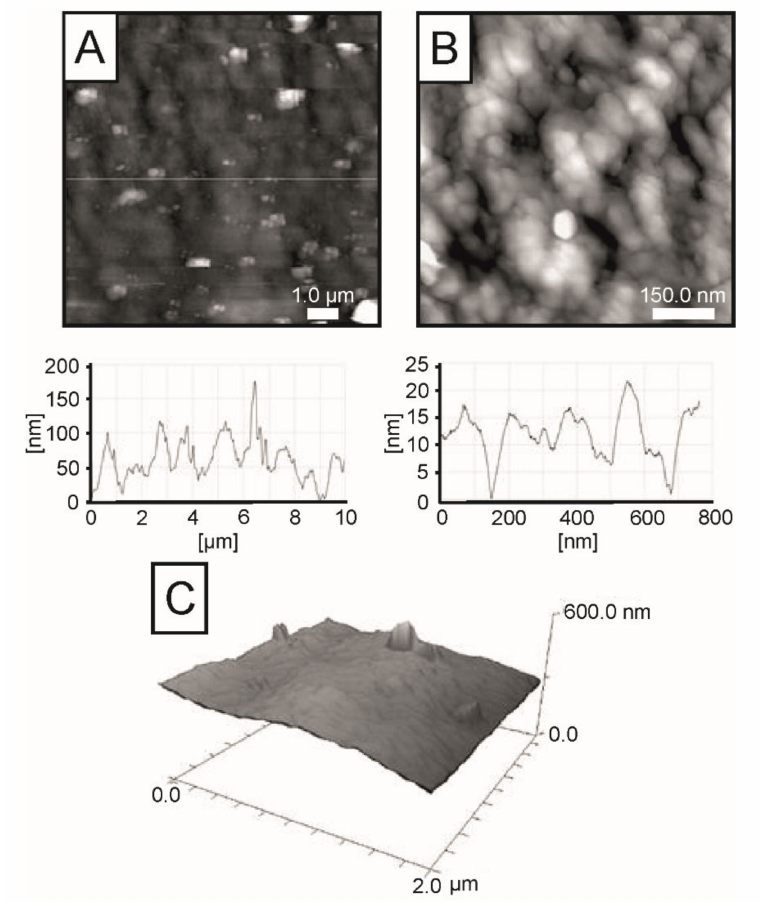
Figure 7. 2D AFM images ( A ) 10 × 10 µ m, and ( B ) 760 × 760 nm with corresponding line profiles and ( C ) 3D AFM image (2 × 2 µ m) of chitosan/1,3- β - D -glucan sample gelled at 90 ◦